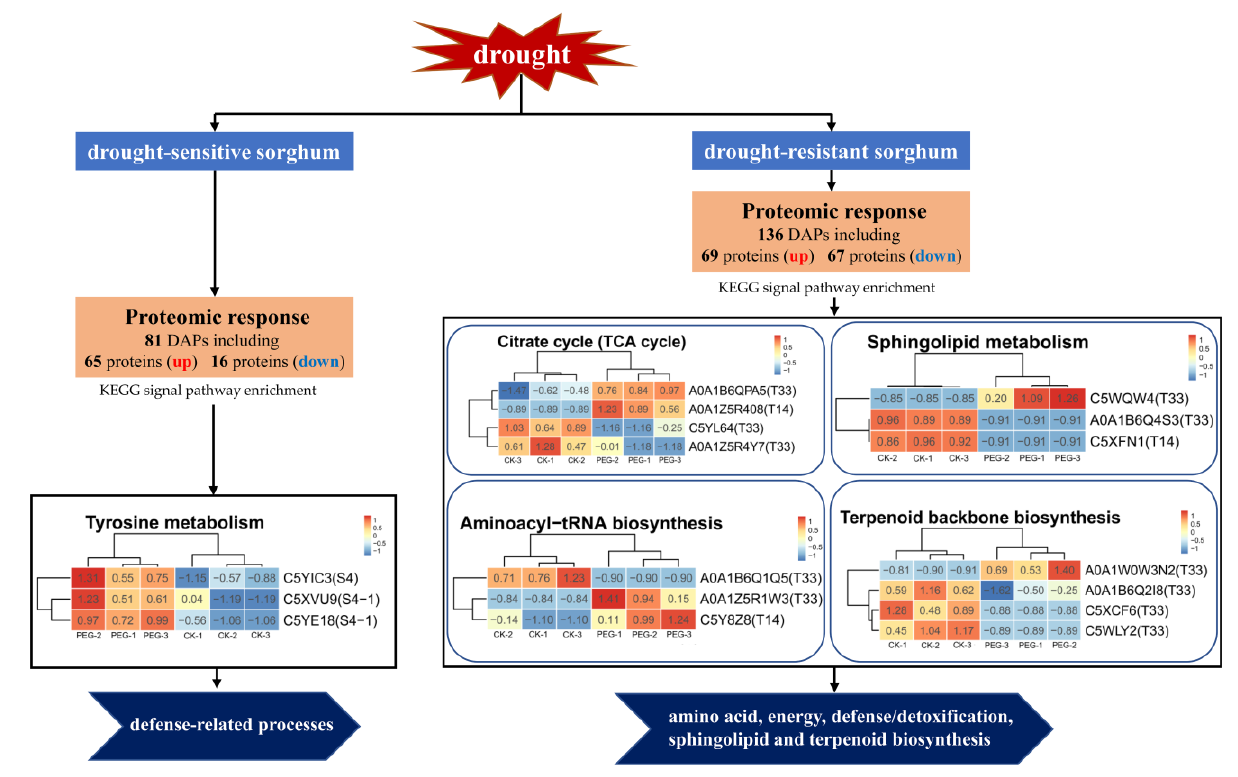
Figure 6. Model showing the proteomic responses of drought-sensitive and drought-resistant sorghum under drought stress.